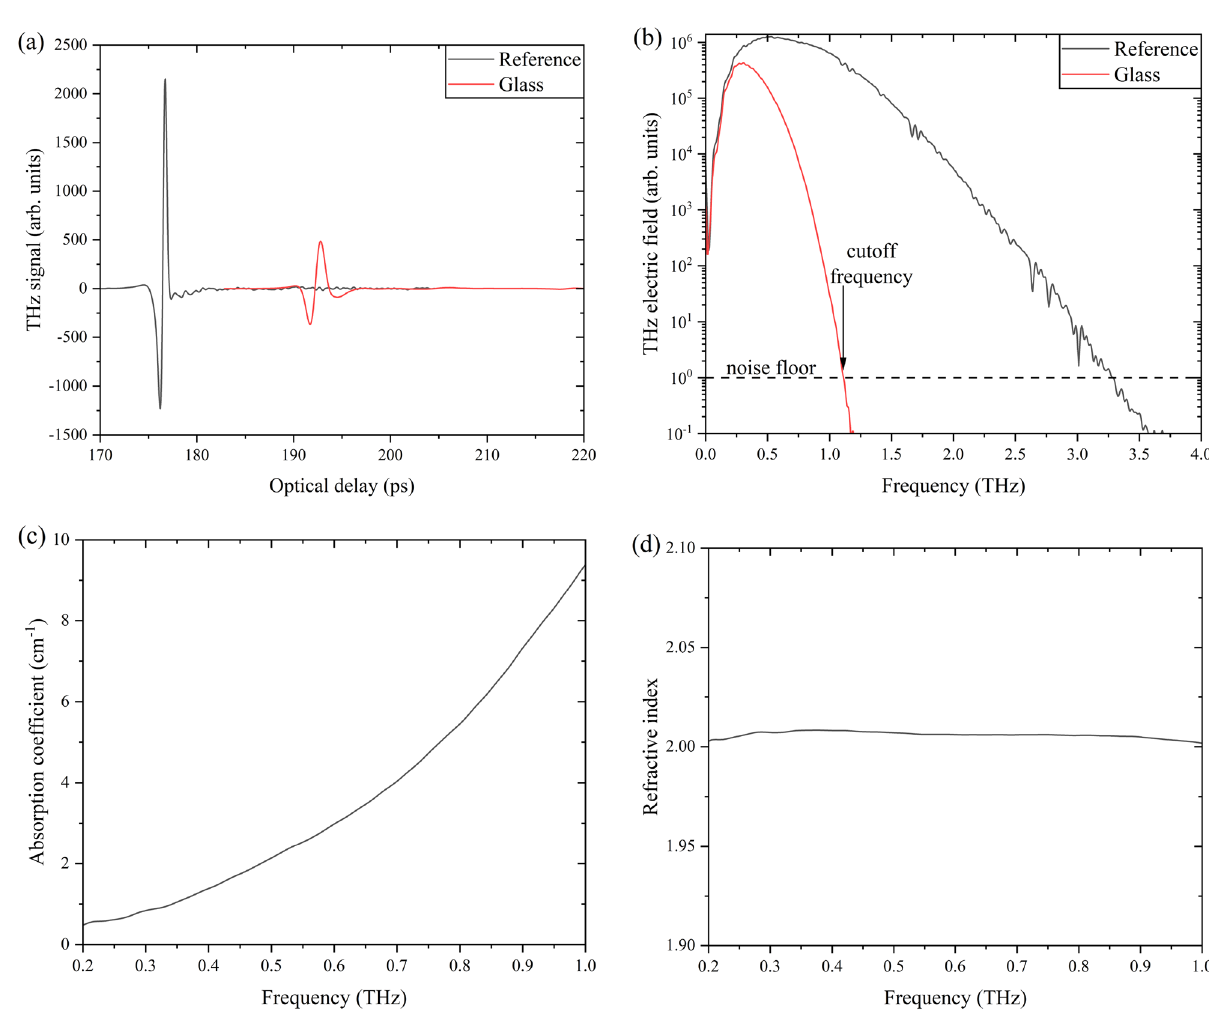
Figure 2. Example set of THz-TDS raw data and resulting optical properties of a glass sample. ( a ) THz time- domain waveform, ( b ) THz electric field frequency domain spectrum, and ( c ) absorption coefficient and ( d ) refractive index spectra of a glass sample at THz